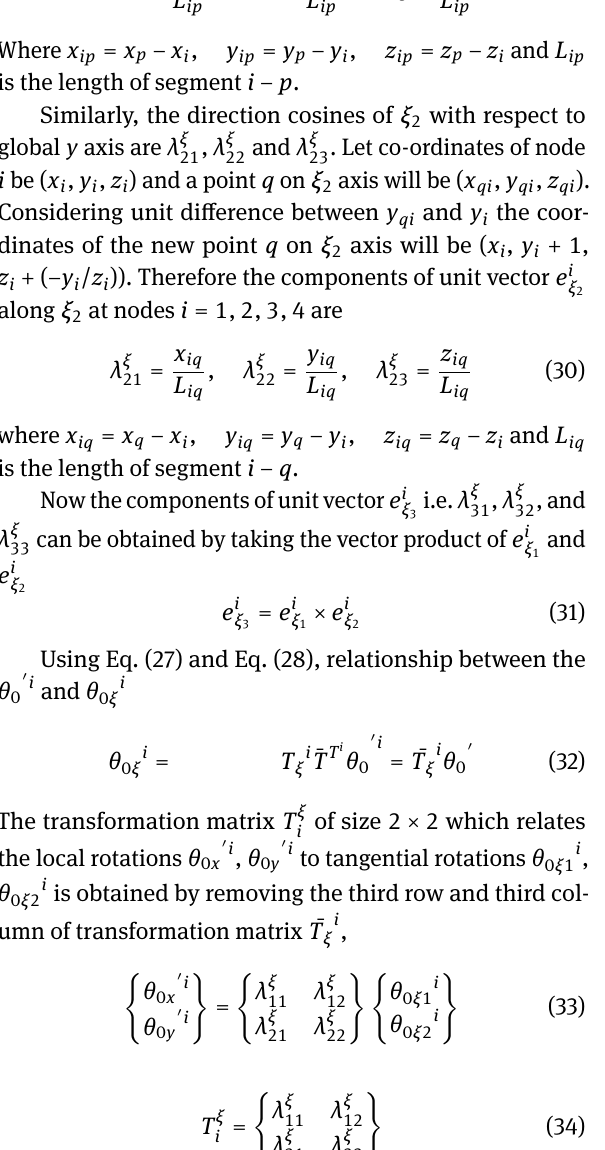
x pi and x i the coordinates of the new point p on ξ 1 axis will be ( x + 1, y , z + (− x / z )). Therefore the components i i i i i